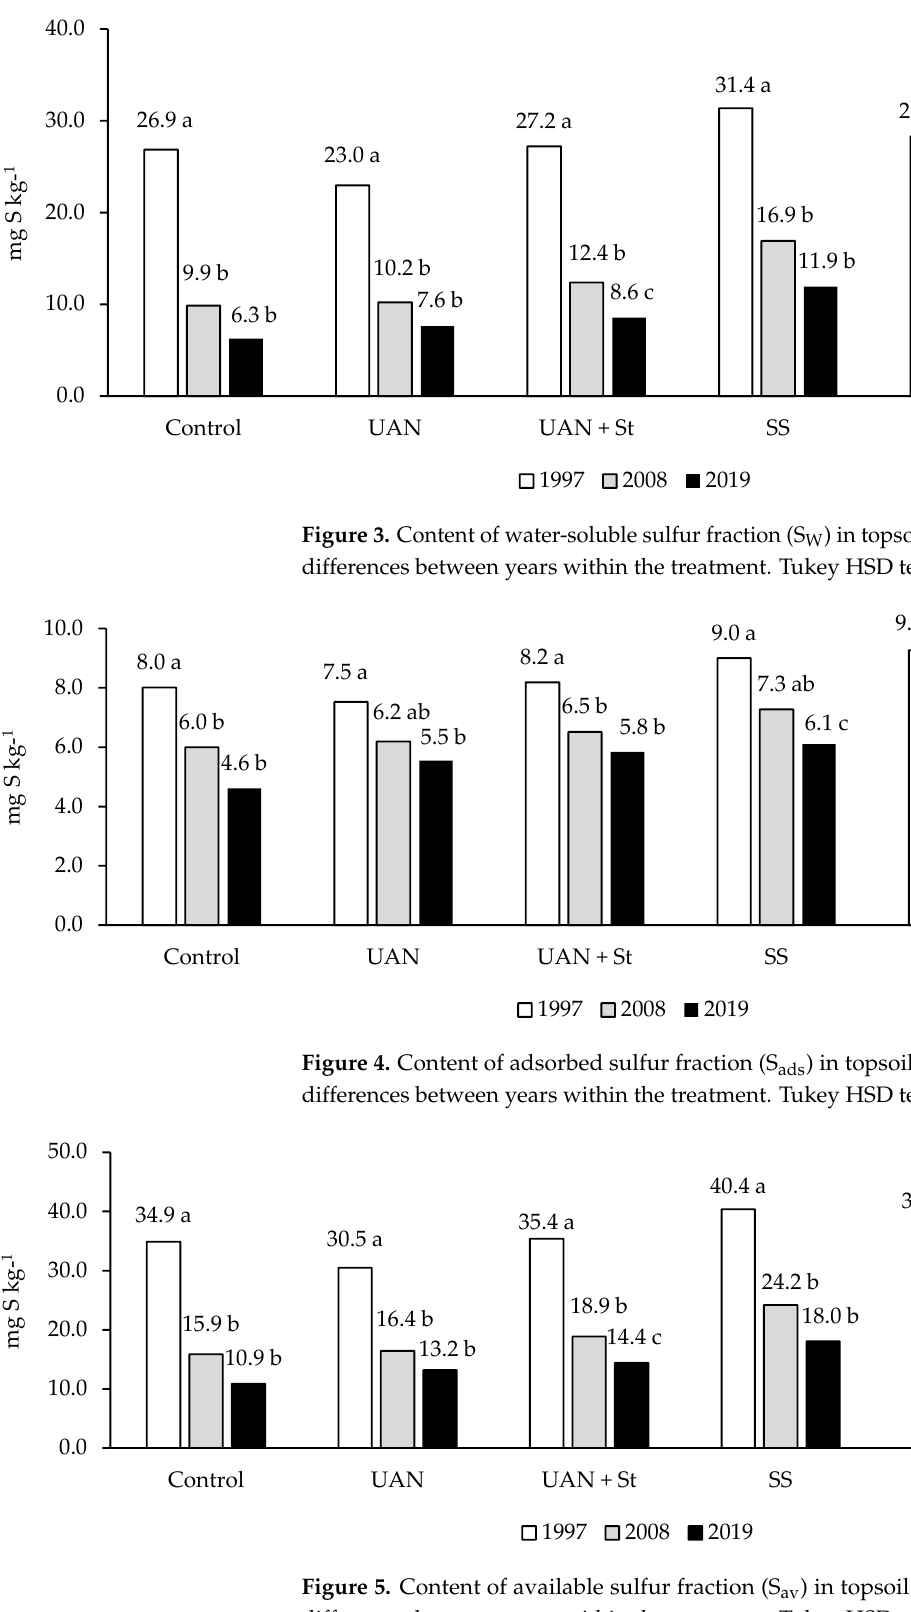
Figure 6. Content of Mehlich 3 extractable sulfur fraction (S M3 ) in topsoil. Different letters describe significant differences between years within the treatment. Tukey HSD test ( p < 0.05), ( n = 4). The significantly decreasing soil sulfur pools were found even in the S pt (Figure 7) fraction with few exceptions. Firstly, although the SS treatment showed a decreasing trend, due to variability in results, the decrease was insignificant. Given several more years, the situation would be likely to change. The second exception was the FYM treat- ment, which produced insignificant changes. The FYM and SS treatments had, in general , the highest contents of S pt fractions. The percentages present in each column of Figure 7 show the proportion of organic sulfur out of the pseudo - total. It is evident that , in all treatments, the proportion of organic sulfur increased over time. This means that mineral S pools accordingly decreased over the course of the experiment. On average, the propor- tion of S av in S pt in 1997 was 15.4%, while the same proportion in 2019 was only 7 . 7%.